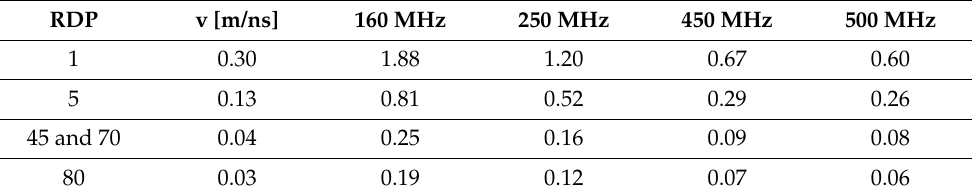
Table 3. Wavelength λ in [m] as function of frequency and RDP, respectively pulse velocity (cf. Conyers [10], p.23). The vertical imaging resolution is dependent on the wavelength, and Cony- ers ([10], p.25) pointed out that under real-world conditions, one wavelength separation is required for resolution, instead of the theoretical minimum of a quarter wavelength. RDP v [m/ns] 160